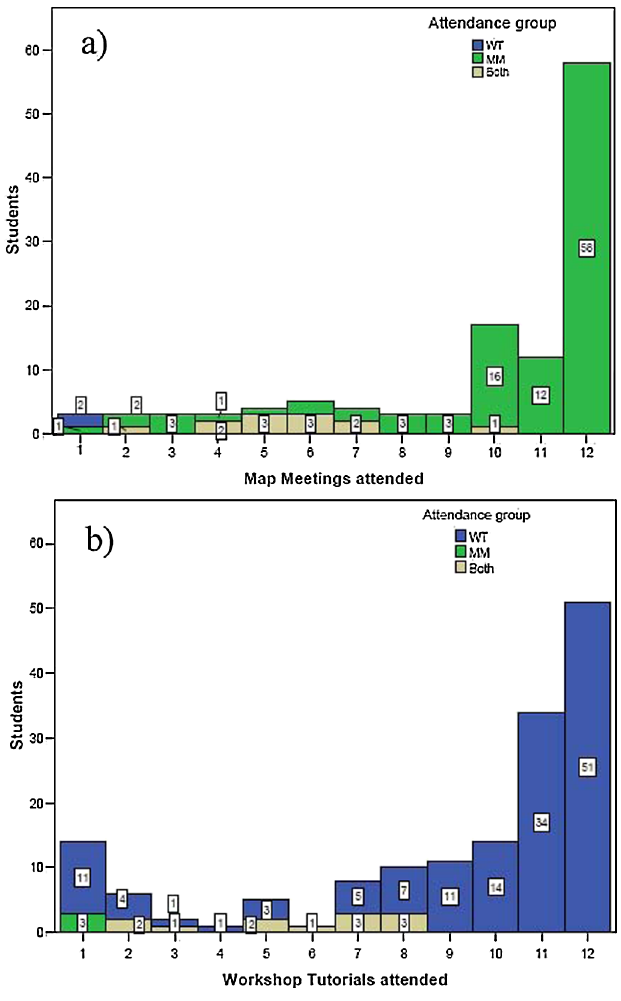
FIG. 4 (color online). Number of Map Meetings (MM) (a) and Workshop Tutorials (WT) (b) attended by students in first semester. With respect to the attendance groups, WT students attended at most one Map Meeting, MM students attended at most one Workshop Tutorial, and the ‘‘Both’’ students attended at least two of each type of